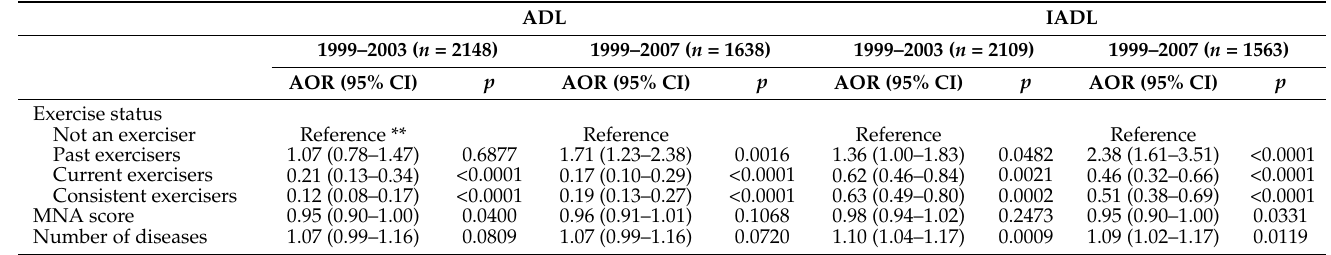
Table 4. Multivariate logistic regression analysis of the associations of change of exercise status during 4- and 8 years, MNA score and number of diseases with ADL and IADL decline over 4-